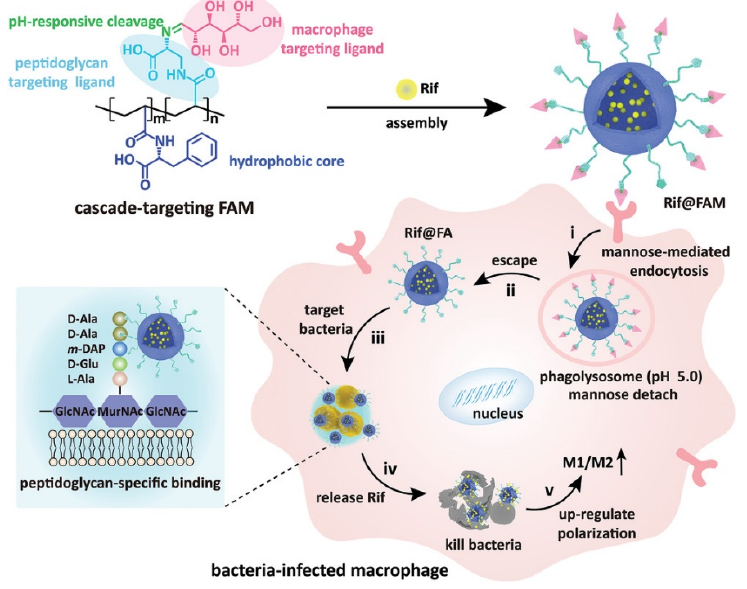
Figure 3. The cascade-targeting DDS eliminates intracellular MRSA. Reprinted with permission from Ref. [52]. Copyright 2022